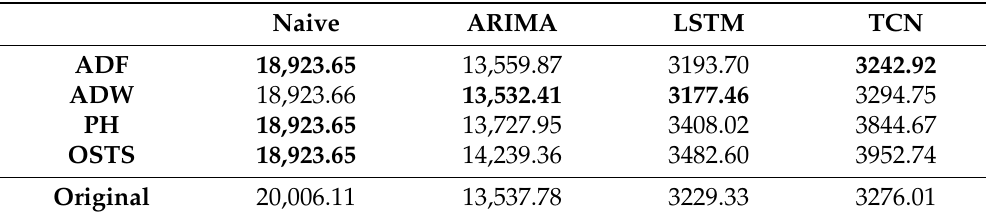
Table 4. Global RMSE results from predictive techniques.